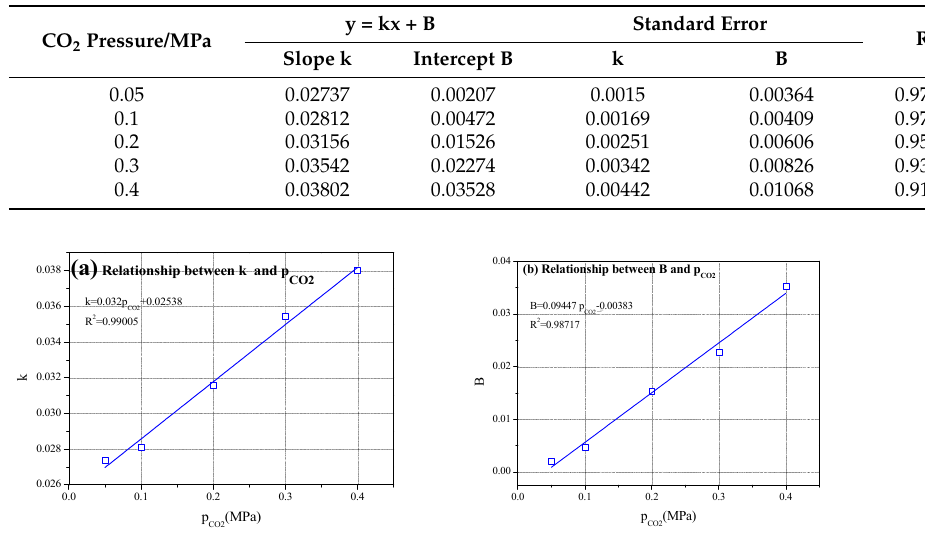
Equation (13) is a carbonization kinetic model based on carbonization time and Table 1. Parameters of linear-regression analysis.